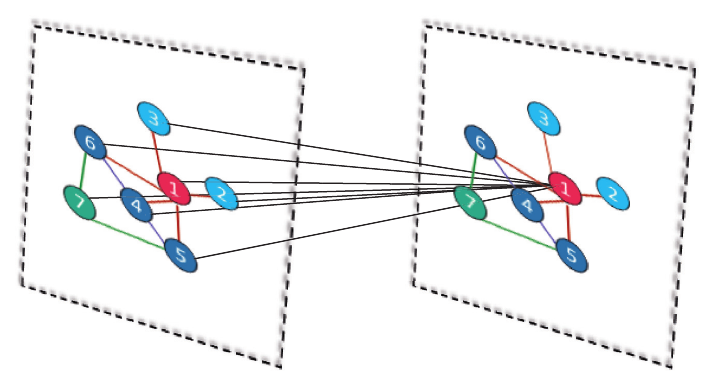
Figure 4: Spatial dependence characteristics of traffic roads.